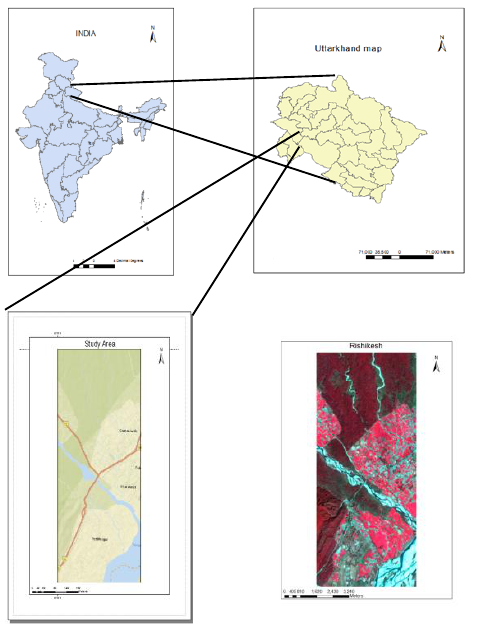
Figure 1 : Study Area